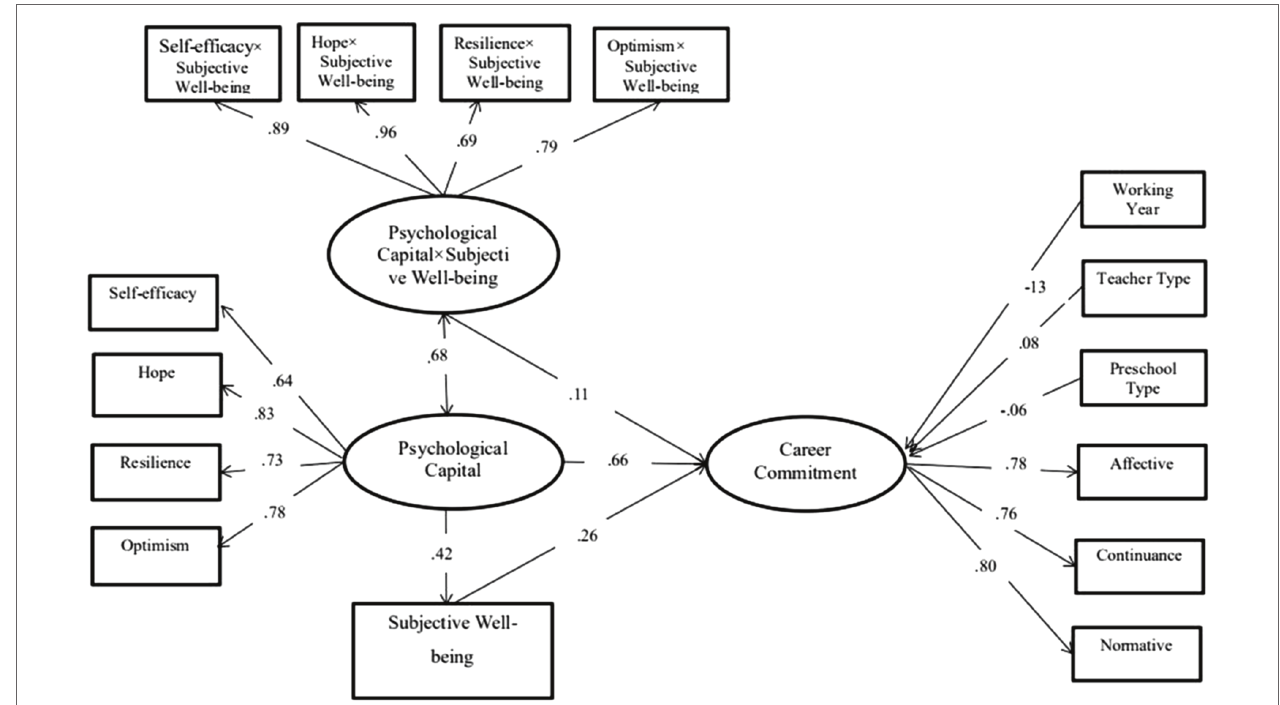
FIGURE 4 | The mediating and moderating effect of SWB on the relationship between PsyCap and career commitment ( N = 759). Significant standardized coefficients were presented. Nonsignificant coefficients were not